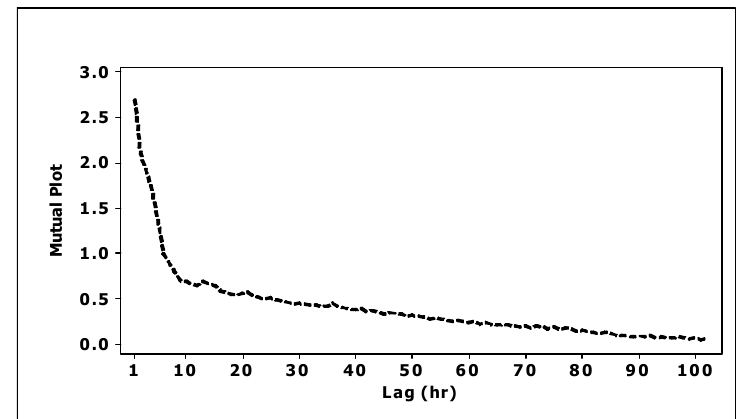
Figure 6. Mutual information of various time-lags.